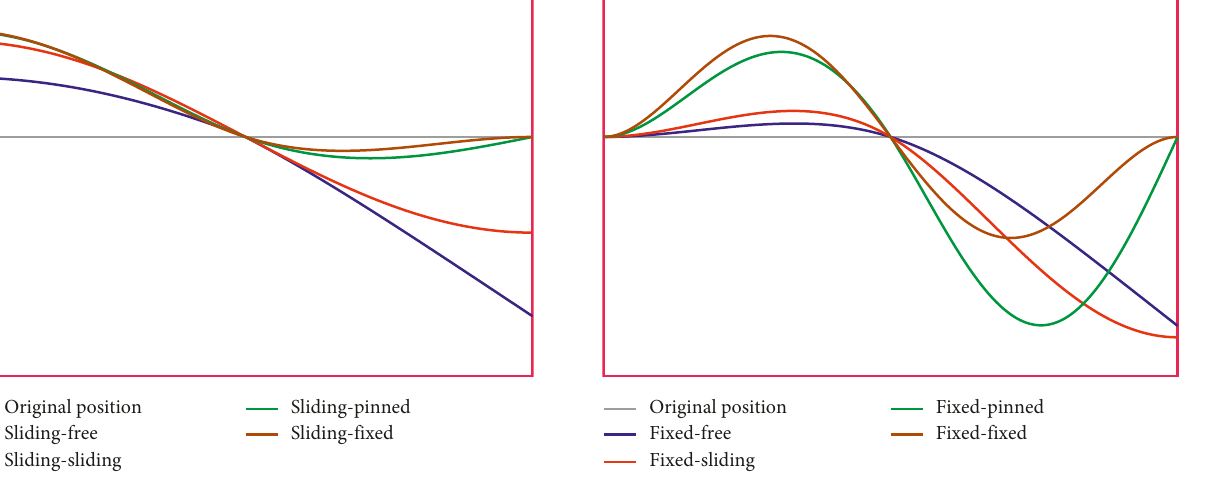
Figure 6: First vibrational modes for two equal span continuous timber floor beams with fixed left ends and various boundary conditions for right ends.